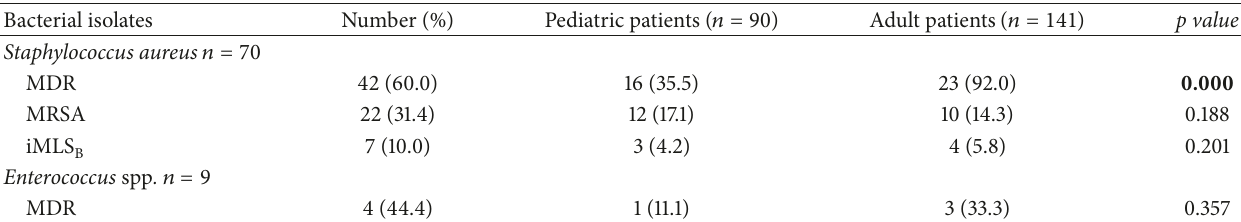
Table 8: Trends of antimicrobial resistance mechanisms in gram positive isolates among pediatric and adult patients ( 𝑛 = 79 ). Bacterial